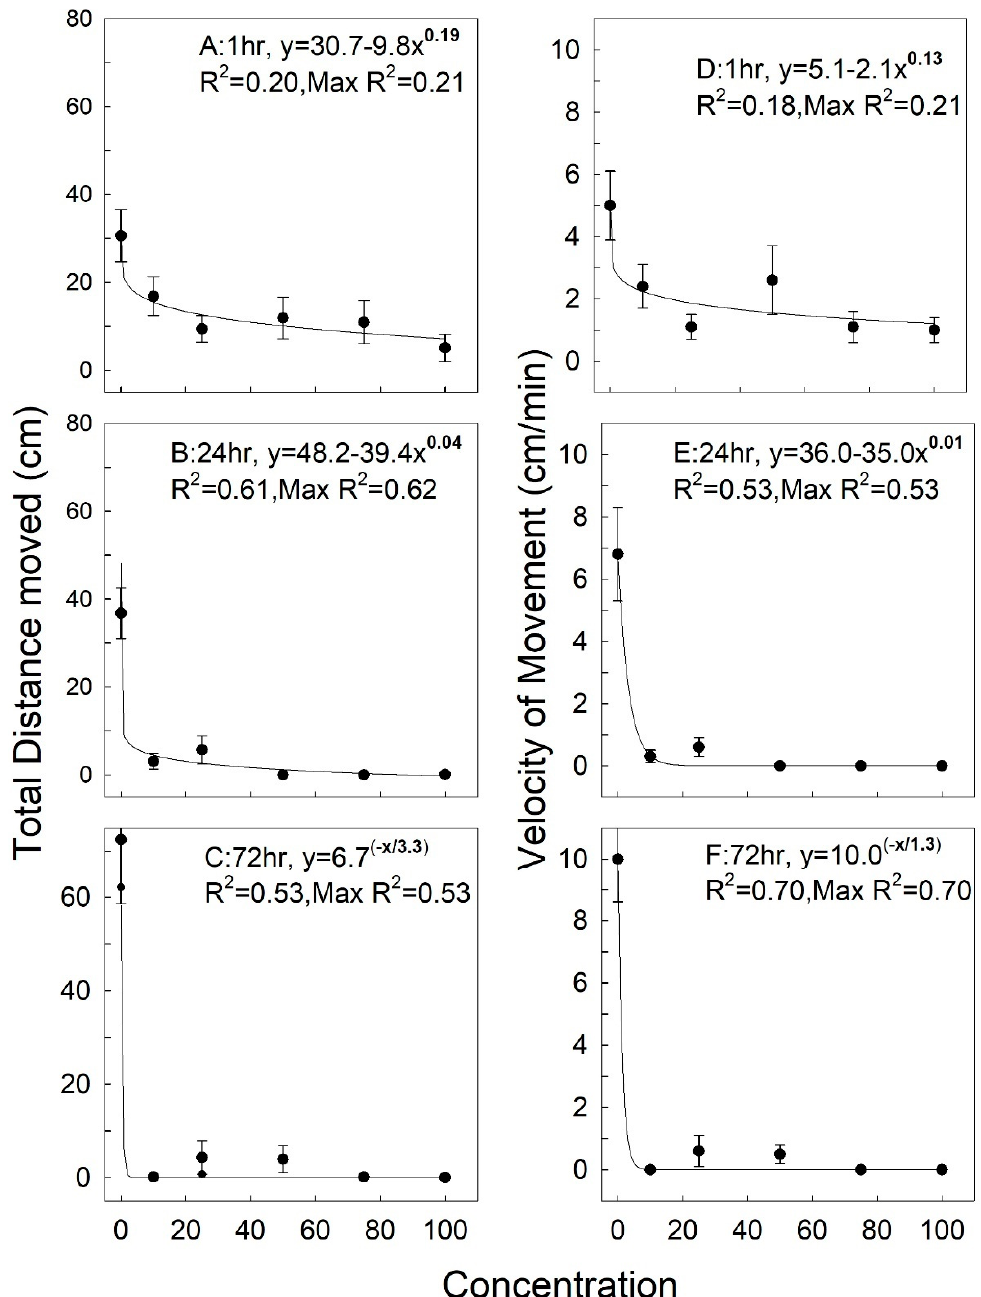
Figure 1. Distance moved (cm) for R. dominica exposed for 1, 24, and 72 h on wheat treated with a combination of deltamethrin, methoprene, and piperonyl butoxide (Figure 1A–C), and instantaneous velocity of movement (cm/min) (Figure 1D–F). Concentration ranged from 0% to 100% of an experimental formulation applied at the rate of 12 mg AI/mL of deltamethrin, 27 mg AI/mL methoprene, and 320 mg AI/mL piperonyl butoxide (PBO) synergist (see Materials and Methods). Equations are curve-fit non-linear equations from Table Curve software, and equations were fit to the raw data (n = 15 replicate for each concentration and each exposure time). The R 2 of the equation is given, along with the maximum R 2 of any curve that could be fit to the data set.